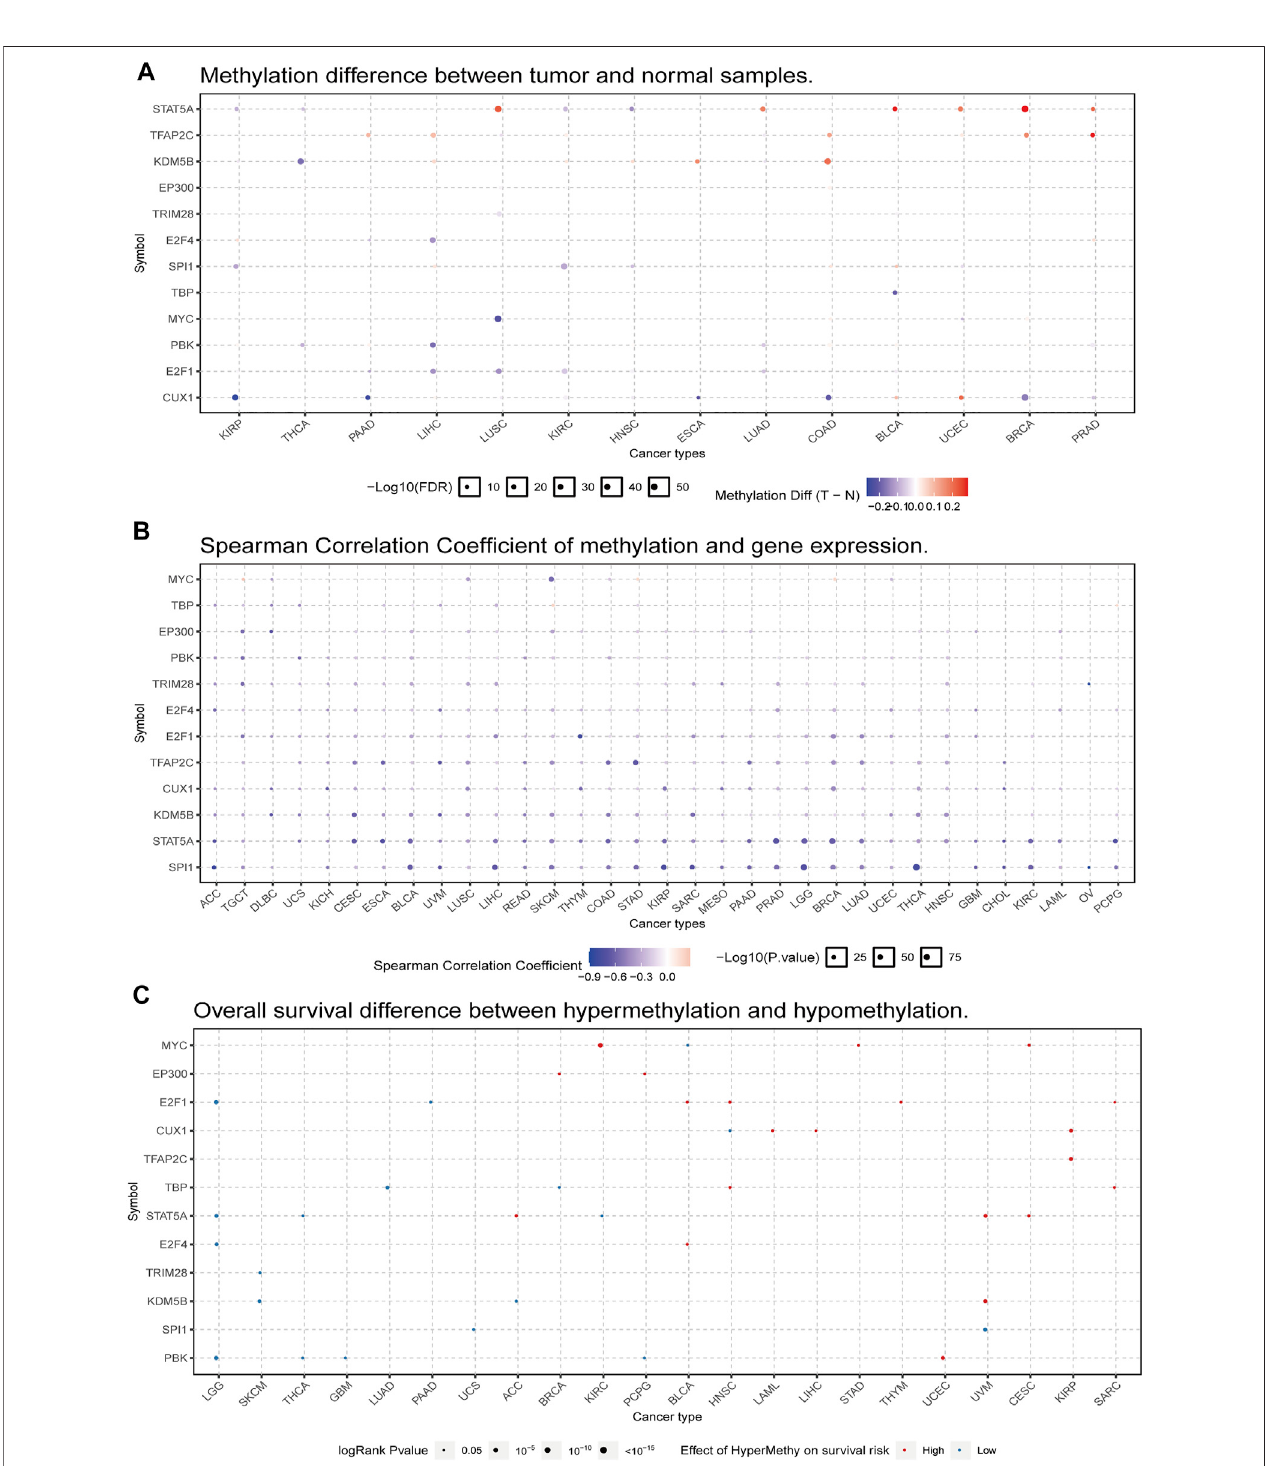
FIGURE 5 | PBK gene methylation in TCGA cancer tissues. (A) Bubble map of the differential methylation of PBK and TFs between tumors and corresponding normal tissues in 14 cancer types. Red and blue dots indicate increased and decreased methylation, respectively, in cancers vs normal tissues. (B) Bubble map of the association between methylation and expression of PBK and TFs across different cancer types. Red dots represent increased methylation and expression levels, and blue dotsrepresent increasedmethylationanddecreasedexpressionlevel. (C) Bubblemap showingtheassociationbetweenOSandmethylationofPBKandTFs in differentcancertypes. Red and blue dotsindicatehigh and lowrisk, respectively. Thesize ofthedotre fl ectsstatisticalsigni fi cance,withalarger sizeindicatinggreater signi fi cance.